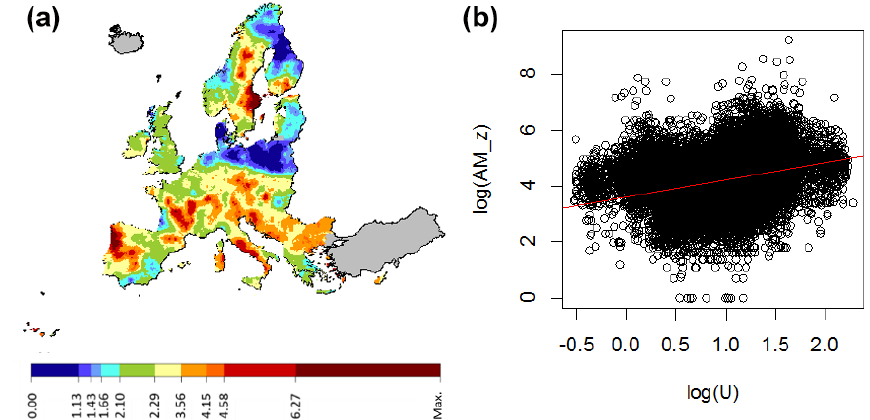
Figure 5. (a) Uranium concentration in topsoil (max = 9.73mgkm − 1 ; Tollefsen et al., 2016) and (b) scatterplot between indoor radon and uranium concentration in